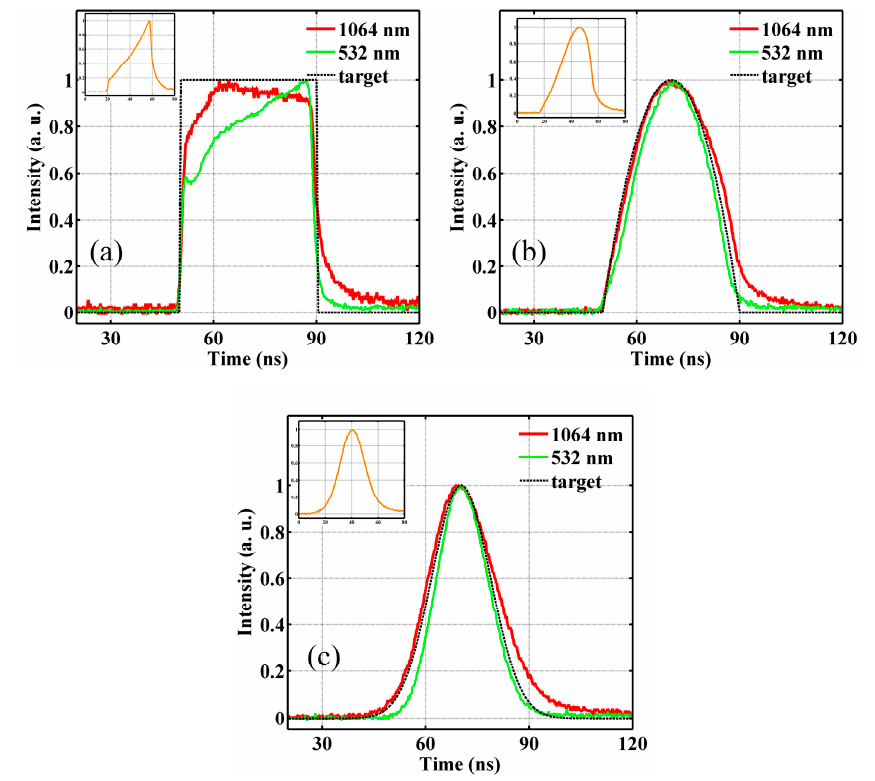
Figure 8. Desired pulse shapes for the 1064 nm and 532 nm at a PRF of 40 kHz. Target is for 1064 nm. ( a ) Square; ( b ) Parabolic; ( c ) Gaussian. (Input pulse shape is given in the inset).